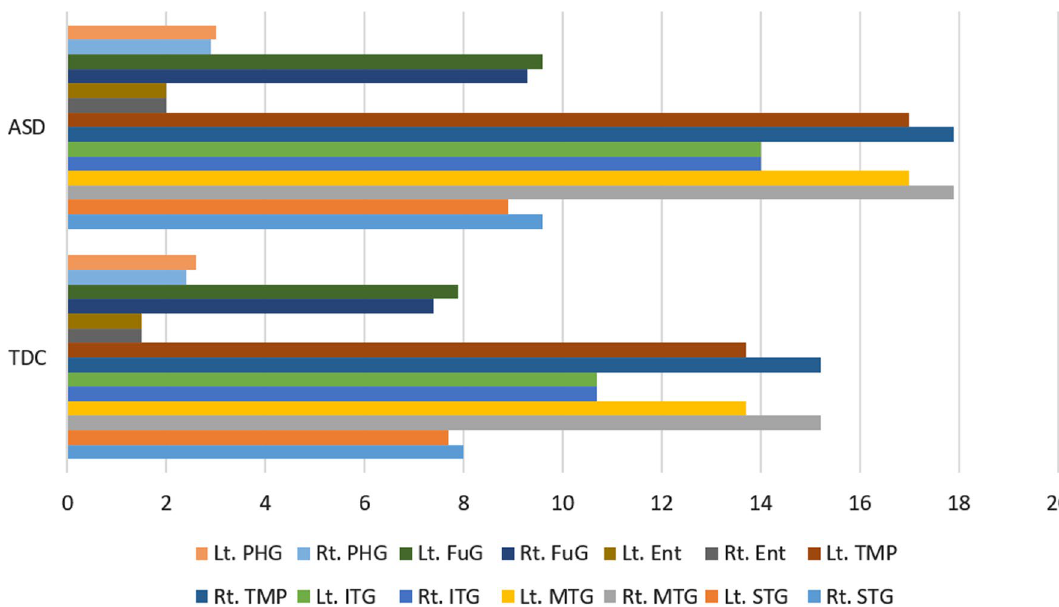
Fig. 3 Anterior temporal lobe (component of social brain) mean volume in TDC and ASD groups. PHG Parahippocampal gyrus, FuG Fusiform gyrus, Ent Entorhineal cortex, TMP Temporal pole, ITG Inferior temporal gyrus, MTG Middle temporal gyrus, STG Superior temporal gyrus